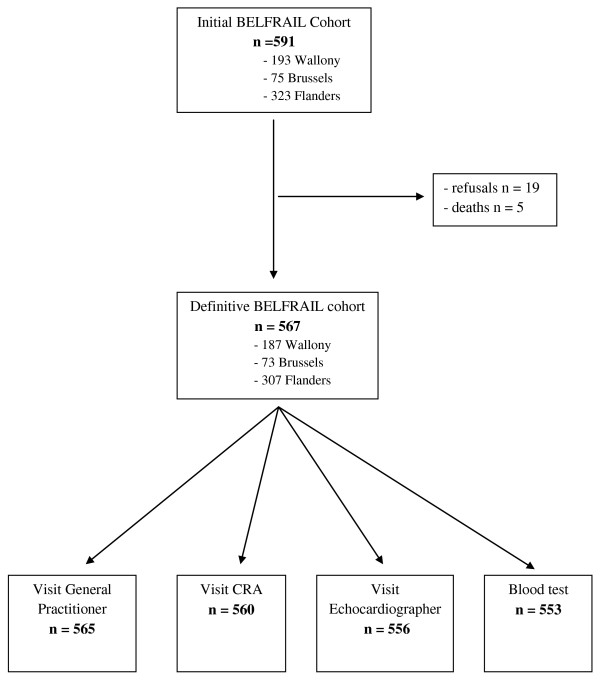
Inclusion of study participants.